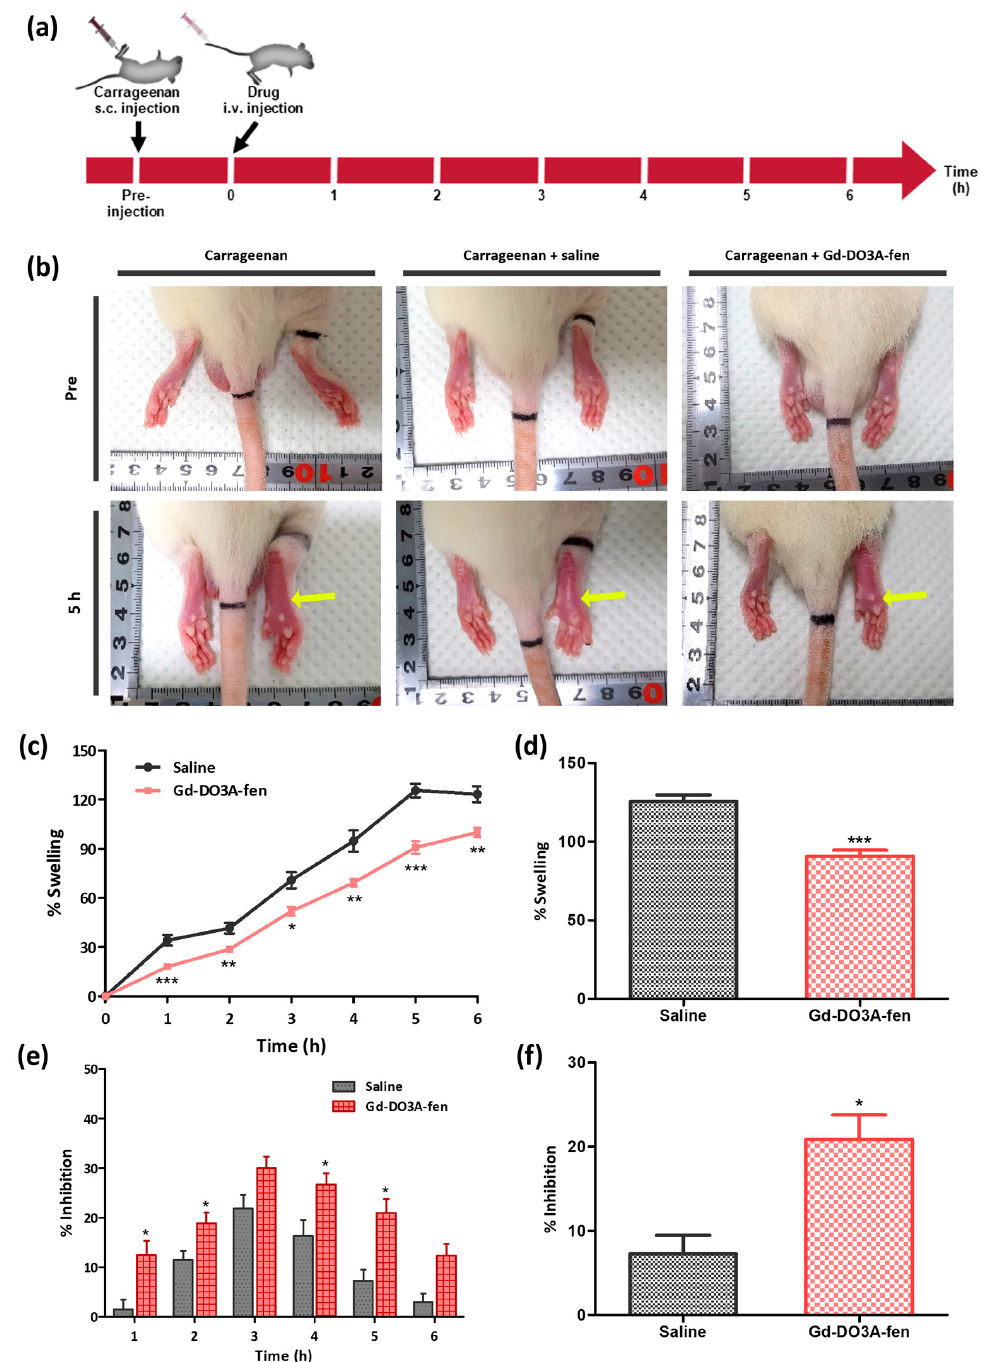
Figure 5. The inhibitory effect of Gd-DO3A-fen in the carrageenan-induced rat hind paw edema rat model. ( a ) The procedure for monitoring the anti-inflammatory effect of Gd-DO3A-fen on paw edema. The edema volume was measured before injection and at 1, 2, 3, 4, 5, and 6 h after the injection of carrageenan. ( b ) Images showing the rat paw before injection and at 5 h after the injection of carrageenan, respectively: carrageenan, carrageenan + saline, carrageenan + Gd-DO3A-fen. Yellow arrows indicate the carrageenan-induced rat paw. ( c ) Percentage swelling observed in the carrageenan-induced paw edema. ( d ) Comparison of % swelling of Gd-DO3A-fen group and that of saline group at 5 h after injection. ( e ) Percentage inhibition of paw edema by Gd-DO3A-fen and saline. ( f ) Comparison of % inhibition of Gd-DO3A-fen group and that of saline group at 5 h after injection. All values represent mean ± S.E.M. ( n = 4 per group; * p < 0.05, ** p < 0.01, *** p < 0.001 vs. saline group).